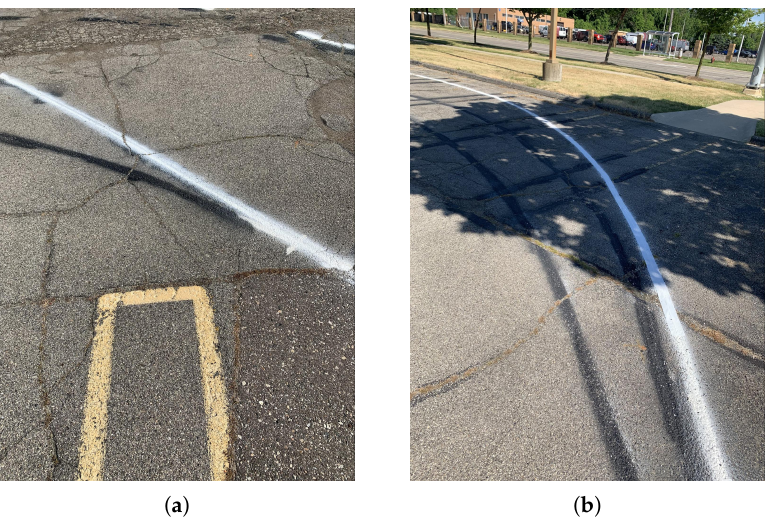
Figure 22. The above images indicate some of the environmental challenges faced. The images are from the test course. ( a ) Yellow parking lines near the lane interfering with yellow line detection; ( b ) Shadows from nearby trees interfering with lane